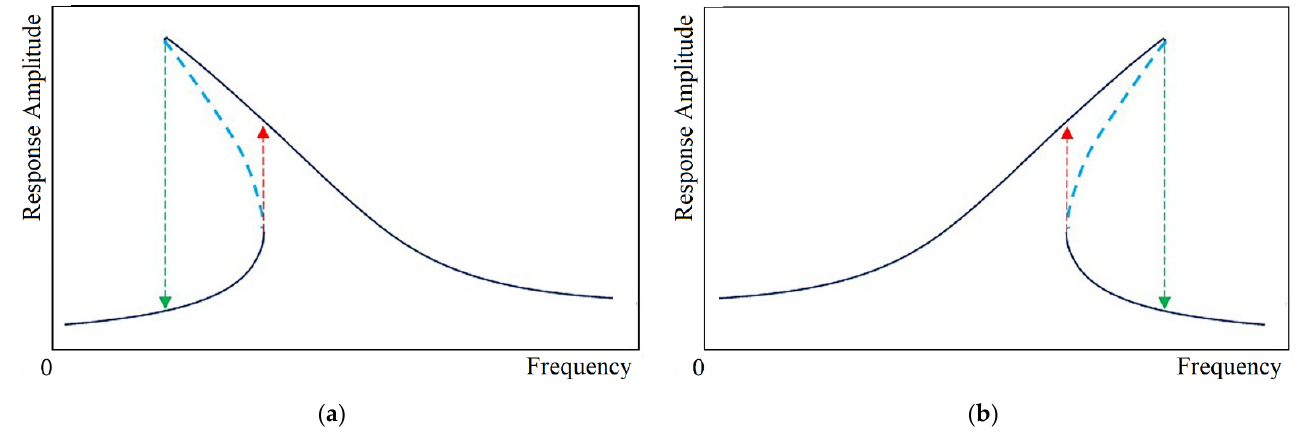
Figure 1. Frequency response curves of the nonlinear deformable structure: ( a ) softening effect with the jumps and frequency sweep direction indicated by arrows, ( b ) hardening effect with the jumps and frequency sweep direction indicated by arrows.